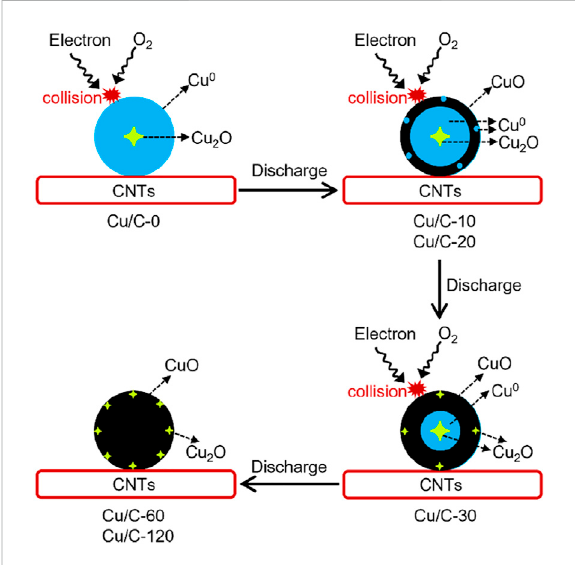
FIGURE 5 Schematic of the preparation process for the catalysts by using the discharge process.